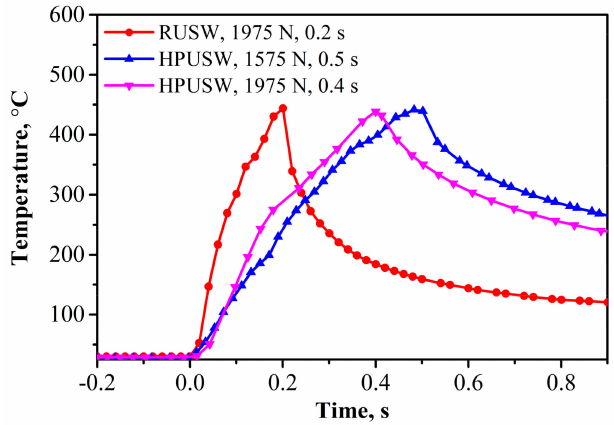
Figure 5. Measured temperature progress with welding time and